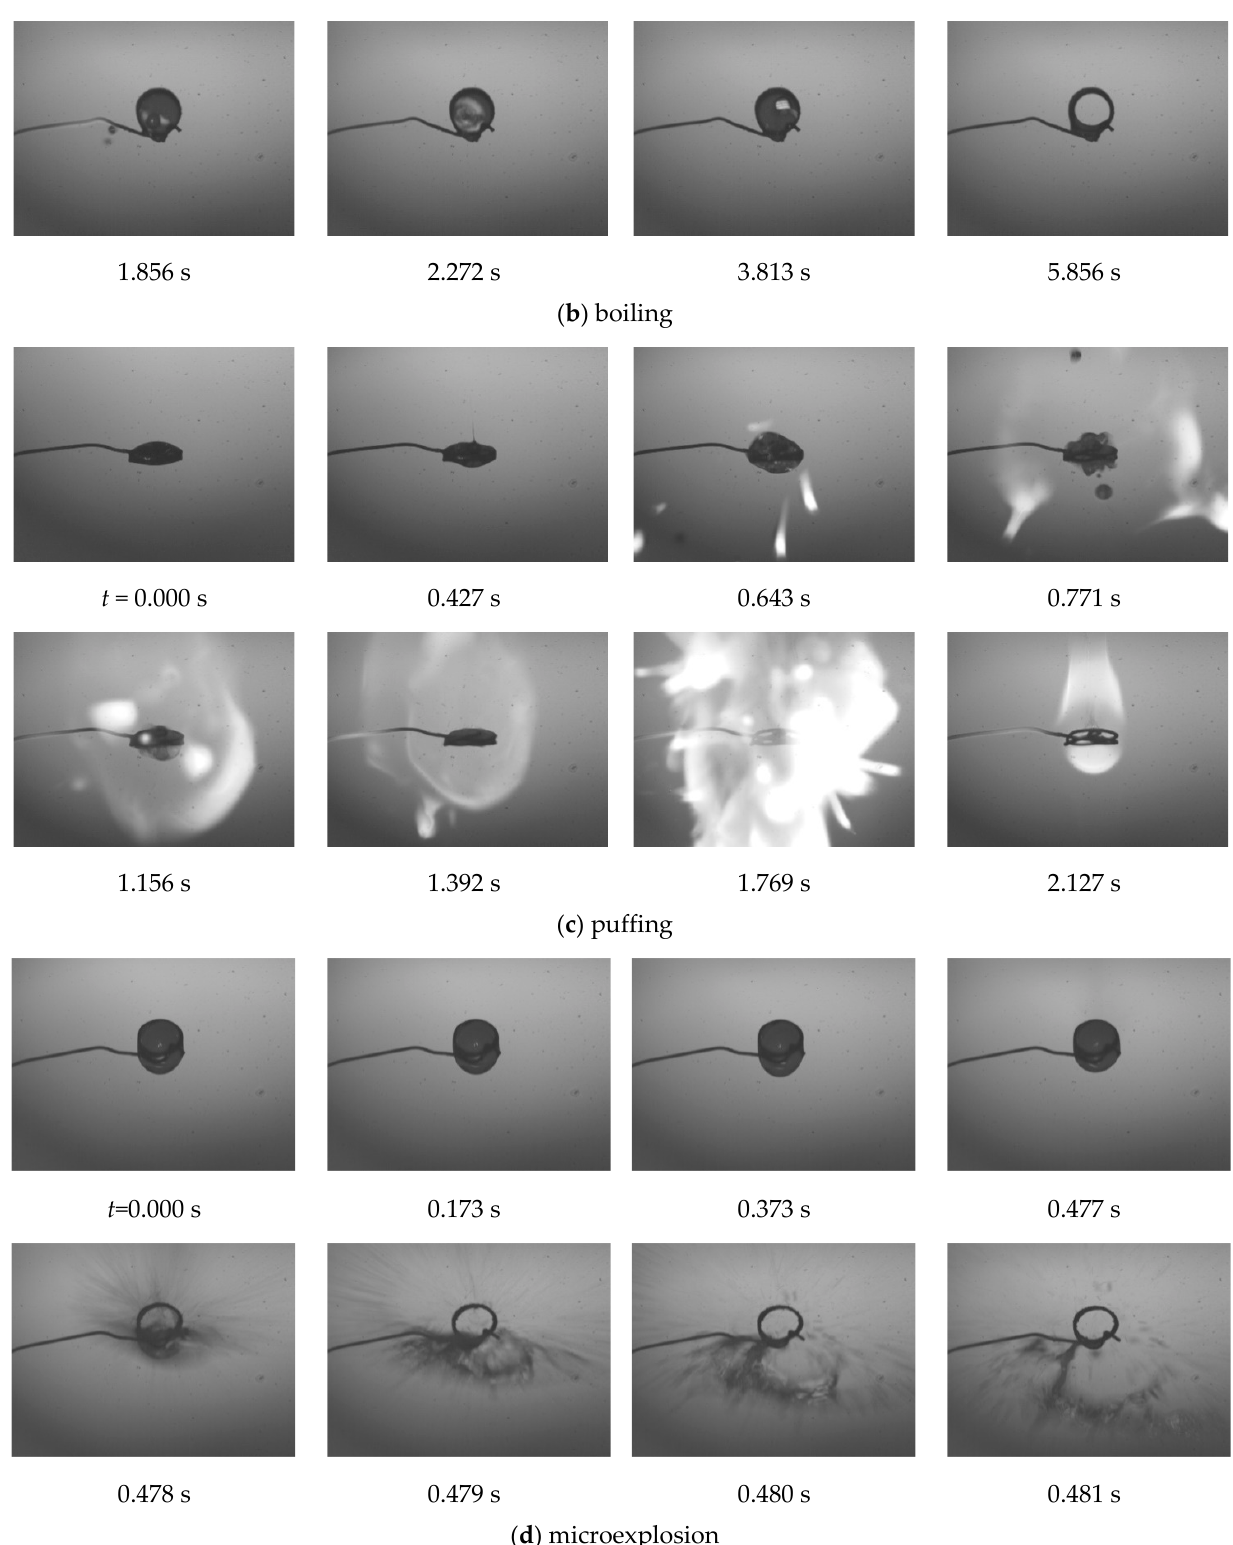
Figure 3. Typical frames of videograms illustrating the four mechanisms of physical and chemical processes during the high-temperature heating of binary liquids: ( a ) evaporation (acetone–95% ethyl alcohol); ( b ) boiling (water–acetone); ( c ) puffing (ethylene glycol–compressor oil); ( d ) microexplosion (monoethylamine–diiodomethane).